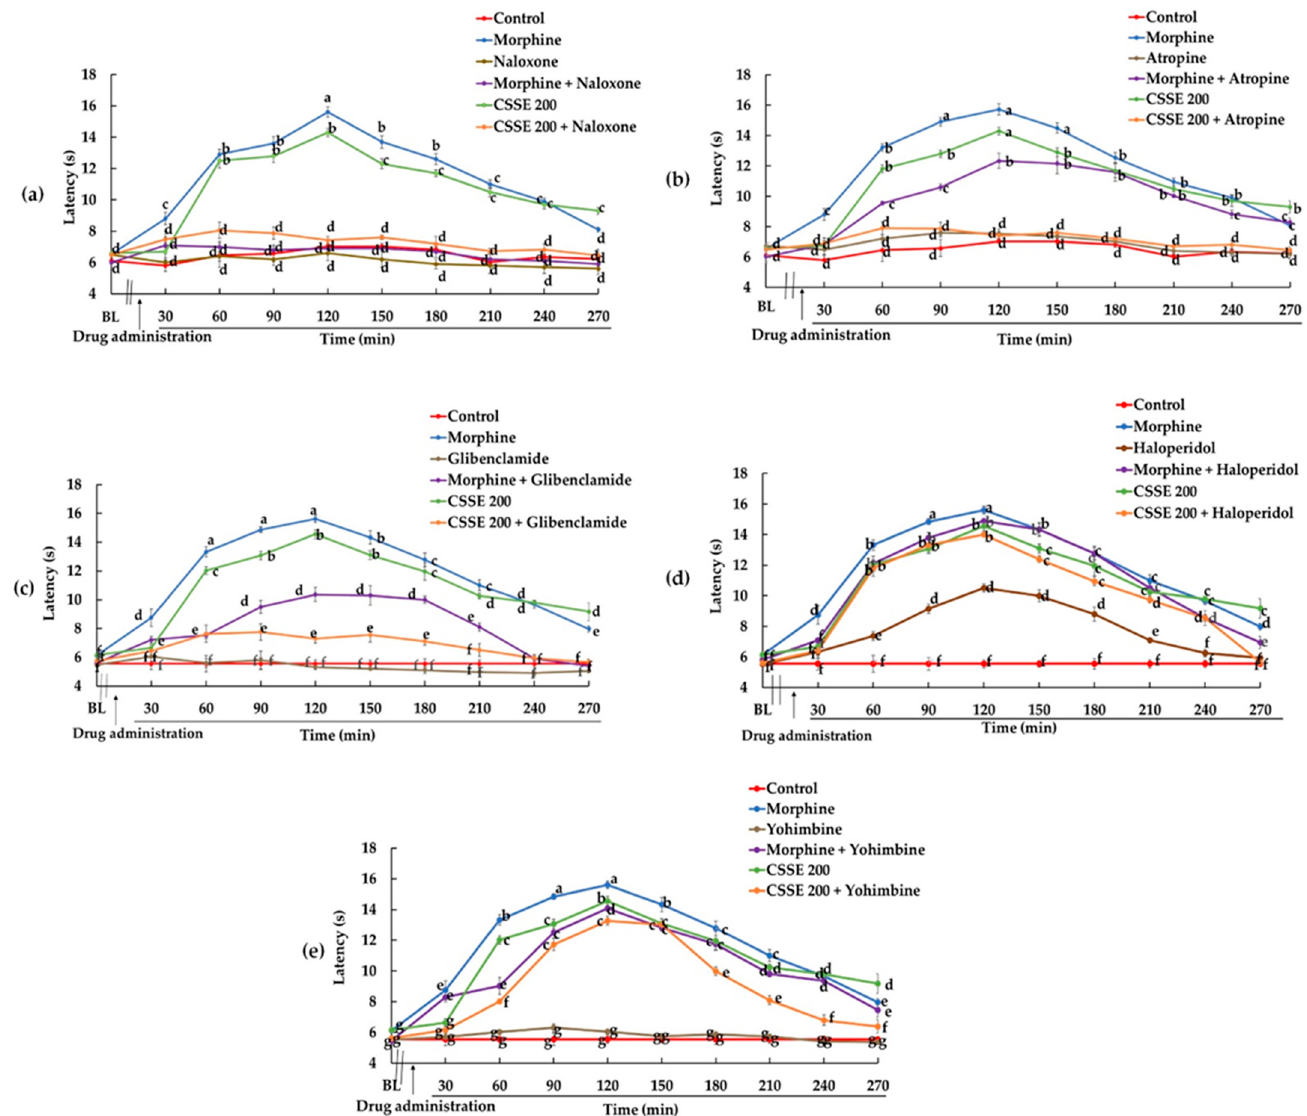
Figure 6. Effect of CSSE on the latency time of mice to react to heat in the hot plate. Mice were pretreated with or without naloxone ( a ), atropine ( b ), glibenclamide ( c ), haloperidol ( d ), and yohimbine I 15 min before administration of CSSE or morphine ( e ). BL: Base Line. Each value represents the mean ± SEM ( n = 6); different letters (a,b,c,d,e,f,g) indicate a significant difference during the duration of the experiment or between treatments ( p < 0.05) (ANOVA II Duncan’s test).